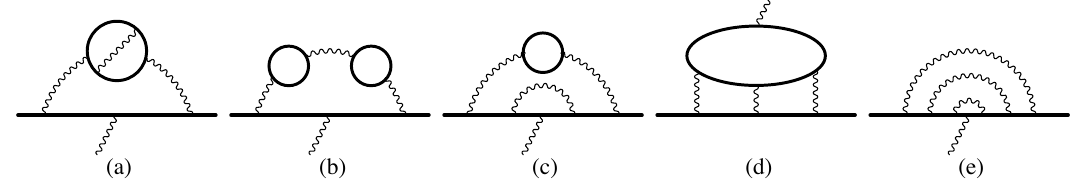
Figure 3. Sixth-order vertex diagrams. There are 72 diagrams in total, and they are divided into five gauge-invariant sets. Typical diagrams from each set are shown as ( a – e ). There are ( a ) 3 diagrams, ( b ) 1 diagram, ( c ) 12 diagrams, ( d ) 6 diagrams, and ( e ) 50 diagrams. The solid and wavy lines represent electron and photon propagators, respectively. Reprinted from [12].